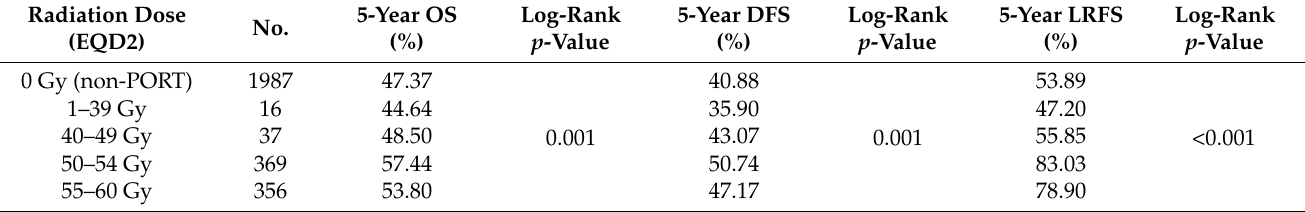
EQD2: equivalent dose in 2 Gy per fraction, OS: overall survival, DFS: disease-free survival, and LRFS: local-regional recurrence free survival.